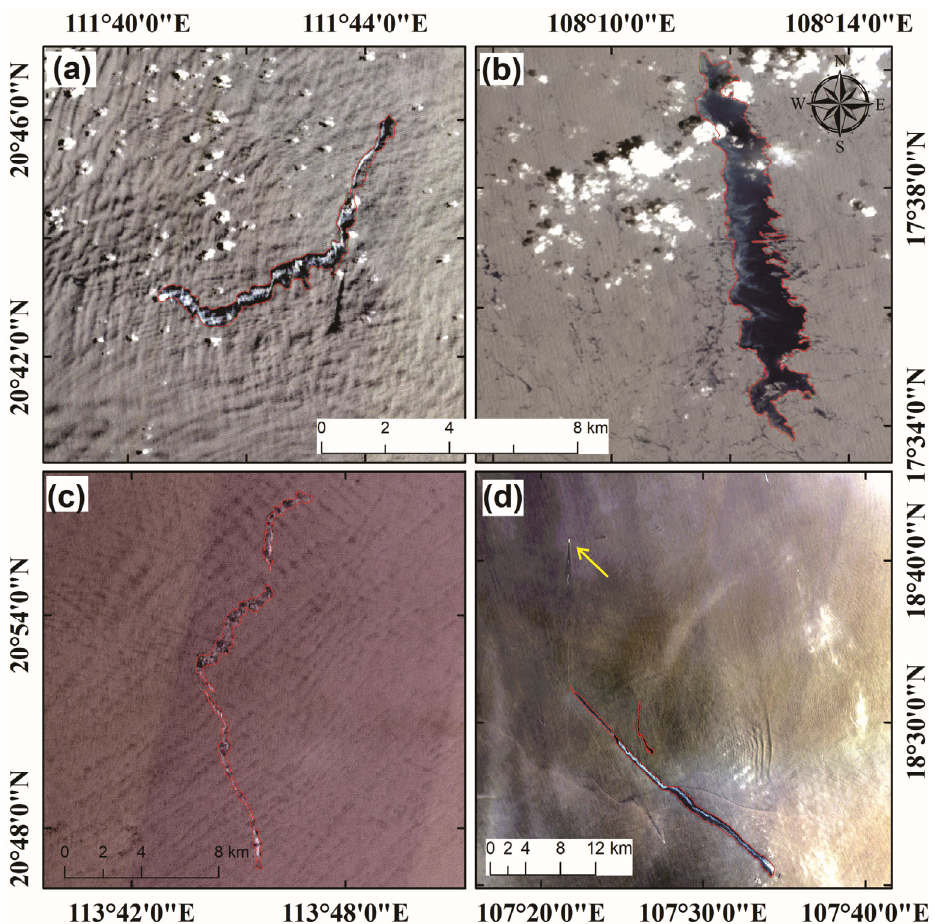
Figure 8. RGB imagery of oil slicks determined from ship sources in cases ( a – d ). Yellow arrow in panel d refers to the associated ship with the slicks.